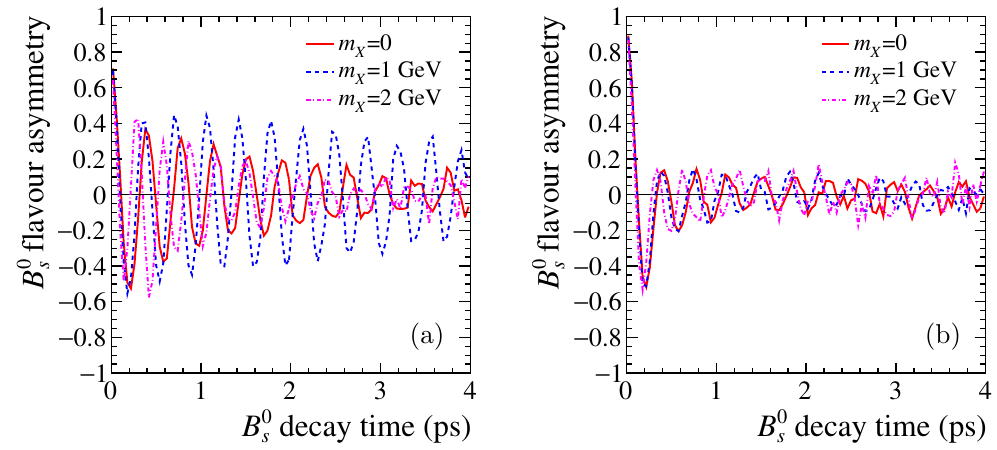
Figure 6 . Dependence of B 0 (cid:13)avour asymmetry on decay time t for the true X mass M X = 1 GeV, s for di(cid:11)erent assigned masses m X , with (a) non-zero longitudinal vertex resolution (cid:27) z = 300 (cid:22) m and perfect transverse resolution, and (b) non-zero transverse vertex resolution (cid:27) x = 40 (cid:22) m and perfect longitudinal